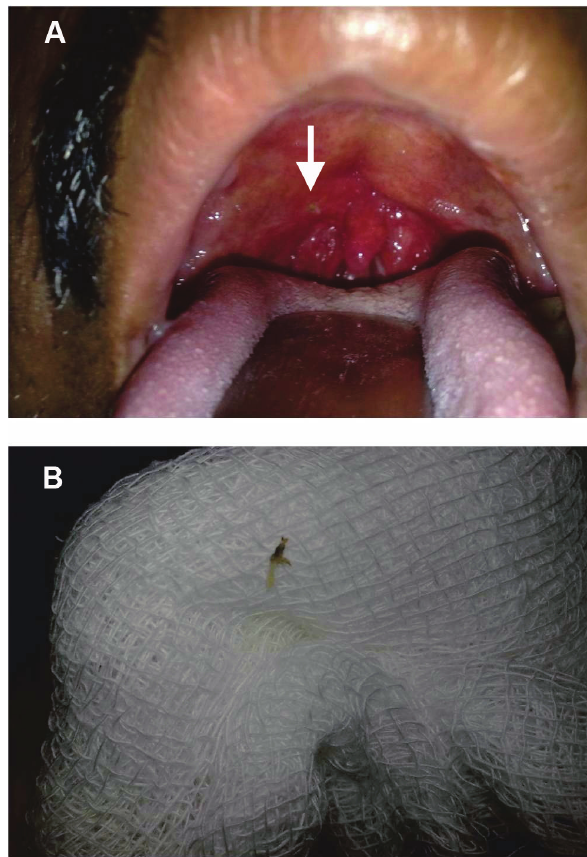
Figure 1. ( A ) Retained stinger on the right soft palate with pus pointing. Surrounding inflamed and swollen uvula and soft palate seen. ( B ) Removed